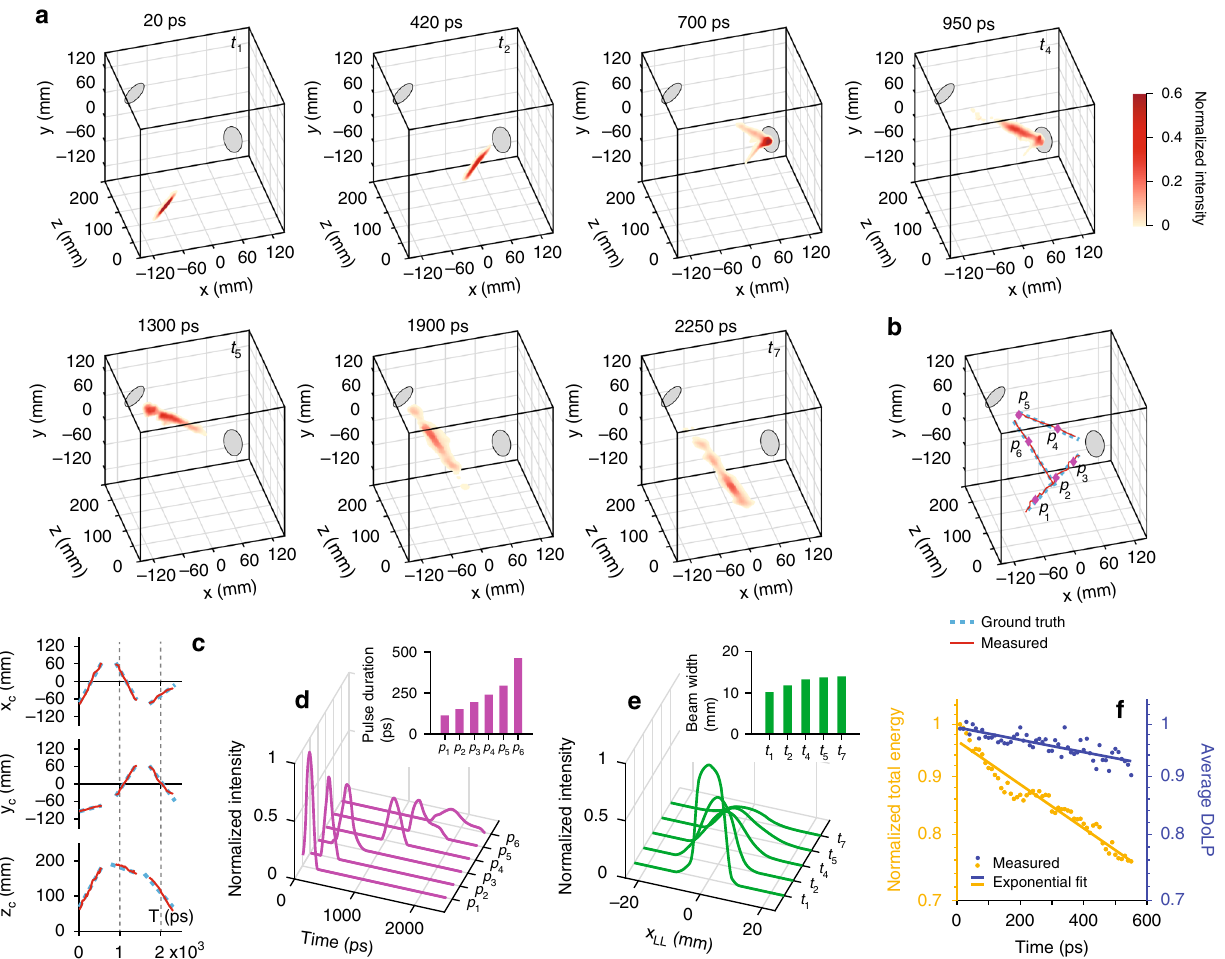
Fig. 5 Stereo-polarimetric ultrafast imaging of an ultrashort laser pulse propagation in a 3D scattering medium. a Seven representative frames of the ultrashort pulse in 3D space, imaged at 100 Gfps. The incident pulse was initially polarized along the y direction. The full movie is in Supplementary Movie 5. A relative depth is used by setting the 600-mm depth as the origin. b , c Traces of both reconstructed (red solid line) and ground truth (cyan dashed line) centroids of the pulse in 3D space b and in three orthogonal spatial dimensions c . d Evolutions of light intensity at six spatial locations ( p 1 – p 6 ) labeled as diamonds in b . Inset: the measured pulse durations at these six locations. e Cross-sections of reconstructed beam intensity in local lateral dimension ( x LL ) at fi ve time points (t 1 , t 2 , t 4 , t 5 , and t 7 ) labeled in a . Inset: the measured beam widths at these fi ve time points. f Reconstructed total intensity integrated over 3D space (left vertical axis and yellow dots) and reconstructed DoLP (right vertical axis and blue dots) before the pulse was incident to the fi rst mirror. Single-component exponential fi ts were applied to both data sets (solid lines). They are plotted on the log